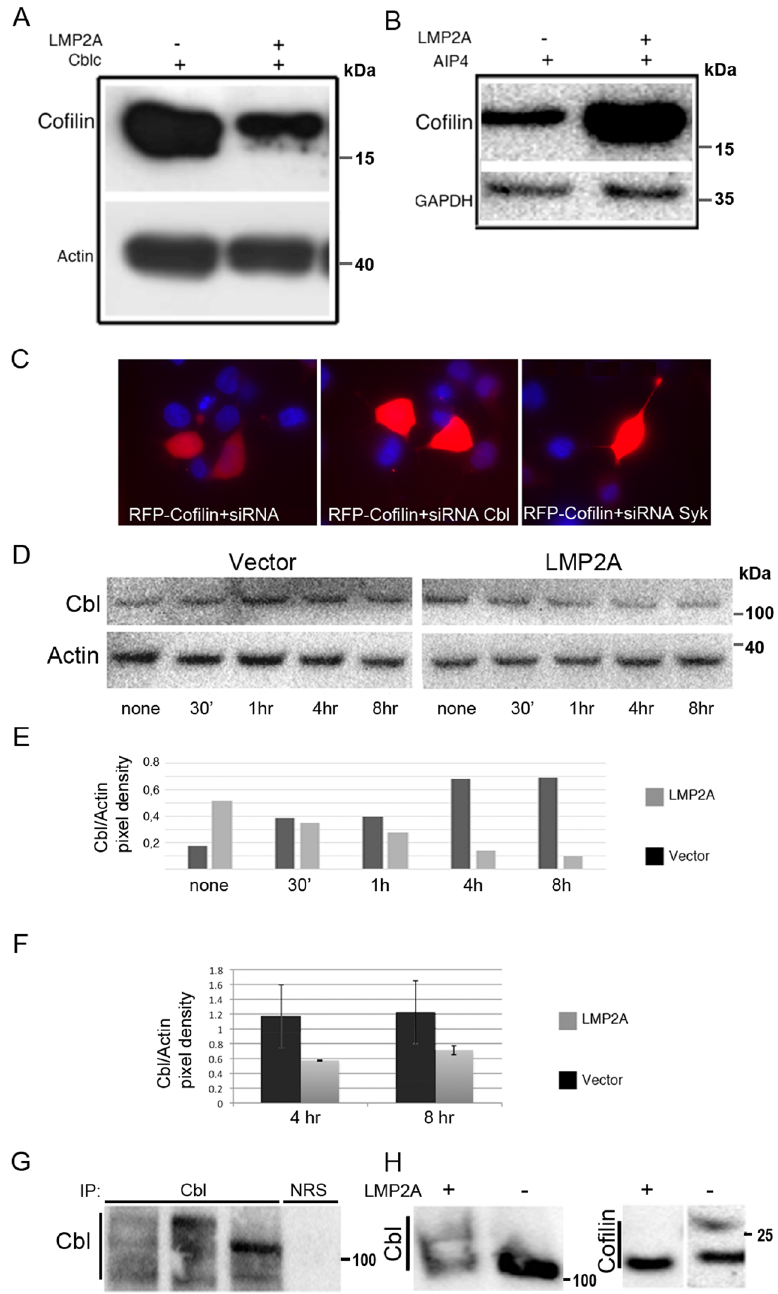
Figure 3. Two ubiquitin E3 ligases are involved in the regulation of cofilin protein stability. WB analysis of cofilin expression in HEK293 cells upon transient expression of either wt Cbl (panel A) or wt AIP4 (panel B) in the presence of LMP2A (left lanes), or in its absence (right lanes). Full-length blots are presented in Supplementary Figure S7A,B. Panel C shows microscopic images of RFP-Cofilin expression in HEK 293 cells, either co-expressed with an irrelevant siRNA (panel C, left image), with siRNACbl (middle image) or with siRNASyk (right image). ( D ) WB analysis of Cbl expression in vector transfected or LMP2A expressing HEK293 cells upon inhibition of proteasomal degradation with MG132. Panel E: Quantitation of Cbl expression from panel D. The staple diagram in panel E shows the ratio of Cbl over actin at the indicated time points after addition of MG132 to the vector (black bars) or LMP2A expressing (gray bars) HEK 293 cell cultures. The staple diagram was generated using the Image J program. Panel F shows the ratio of Cbl over actin in stably transformed LMP2A positive (grey bars) or negative parental (black bars) CNE1 NPC cells. The immunoprecipitations in panel G show the appearance of post-translationally modified (larger) forms of Cbl in LMP2A or shRNAsyk expressing cells. Anti-Cbl and anti-cofilin immunoblots in Panel H show that additional larger forms of Cbl appear (left panel) while one larger form of cofilin (27 kDa) disappears (right panel) in LMP2A positive TWO3 cells. Full-length blots are presented in Supplementary Figure